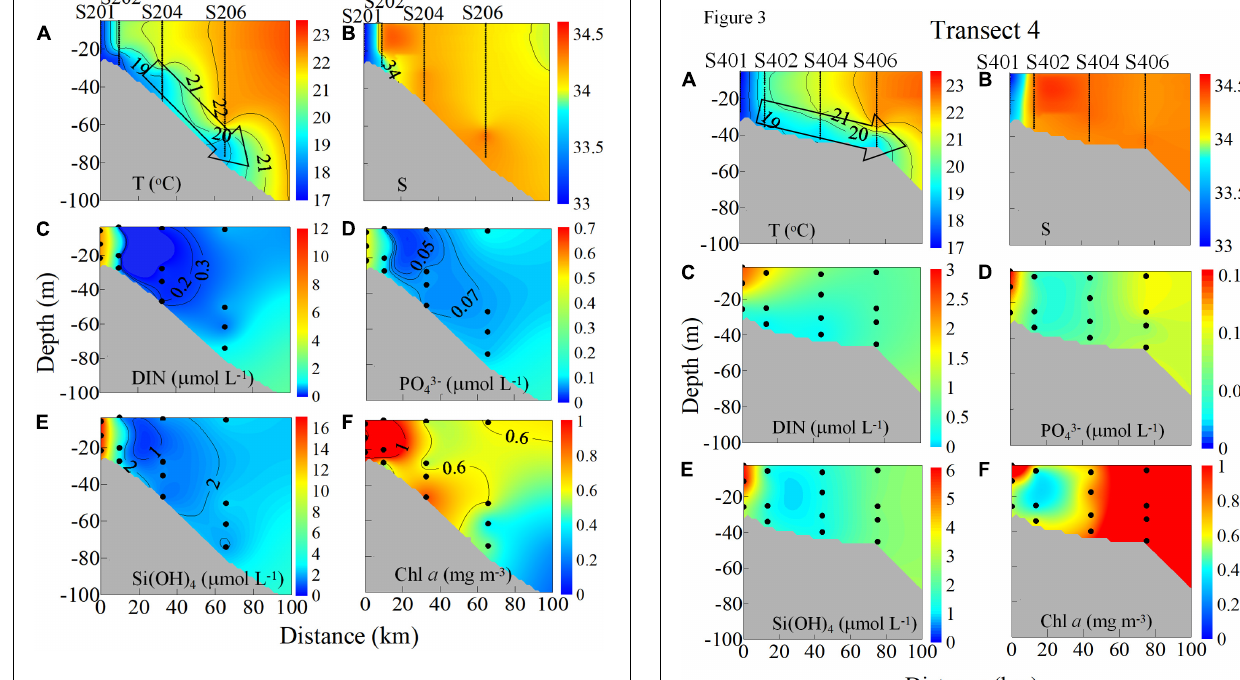
FIGURE 2 | Vertical distributions of (A) temperature ( T ) ( ◦ C), (B) salinity ( S ) (C) dissolved inorganic nitrogen (DIN) (NO 3 − + NO 2 − , µ mol L − 1 ), (D) phosphate (PO 43 − ) ( µ mol L − 1 ), (E) silicate (Si(OH) 4 ) ( µ mol L − 1 ), and (F) chlorophyll a (Chl a ) (mg m − 3 ) along Transect 2 in the NSCS shelf during winter 2008 [redrawn from Figure 5 by Han et al. (2013)].